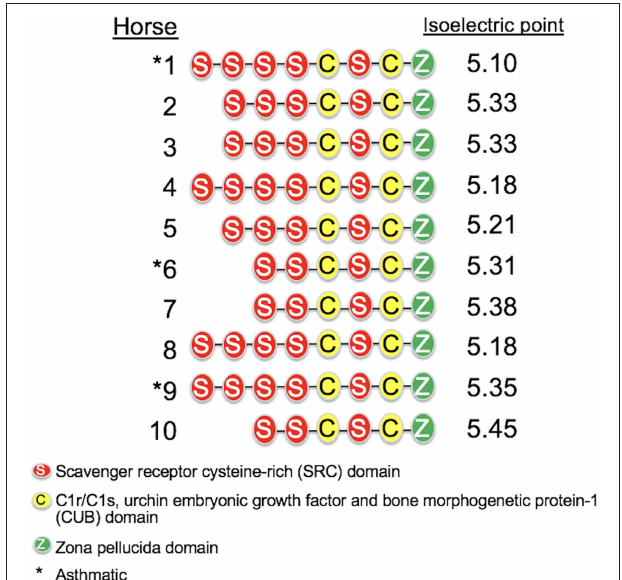
FIGURE 9 | Protein structure of SALSA in 10 horses. The number of SRCR domains varied among horses, indicating different isoforms. The predicted isoelectric point also varied for different isoforms, and was generally higher for shorter isoforms.